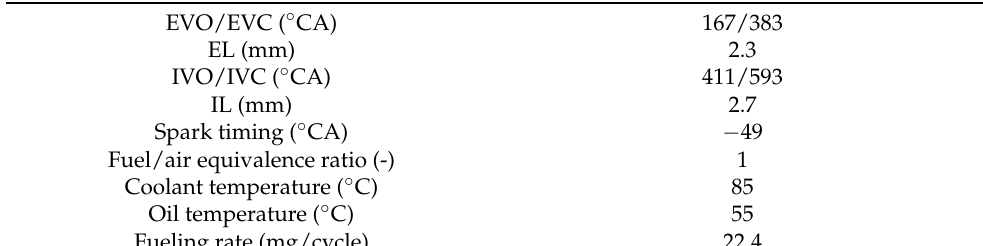
Table 2. Engine operating